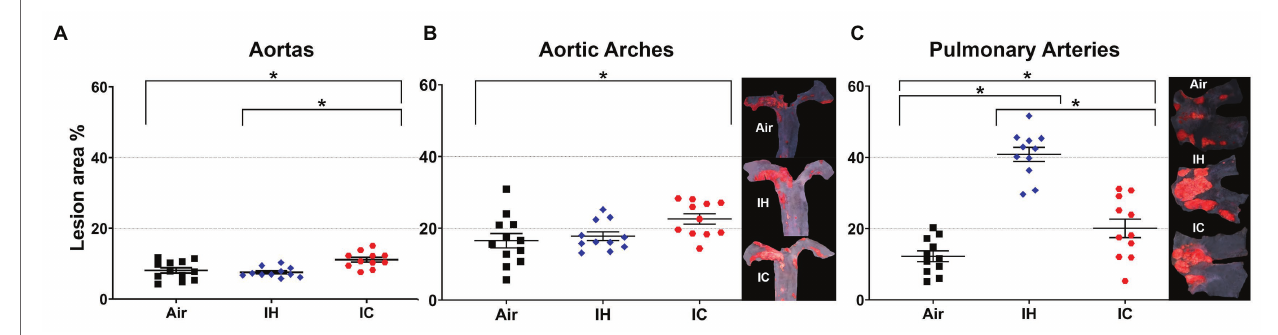
FIGURE 1 | Atherosclerotic lesions in the (A) aortas, (B) aortic arches, and (C) pulmonary arteries of ApoE −/− mice after 10-week treatments. Mice were exposed to either Air, IH, or IC for 10 weeks. The en-face lesions were quantified as the percentage of lesion area in the total area of the blood vessel examined. Side panels: representative Sudan IV-stained images of aortic arch (B) and PA (C) . In the aortas and aortic arches, n = 12 for Air, n = 11 for IH, and n = 11 for IC. In the pulmonary arteries, n = 11 for each Air, IH, and IC group. Data were presented as means ± SEM. Statistical significance (one-way ANOVA with Tukey’s multiple comparison test), * p <